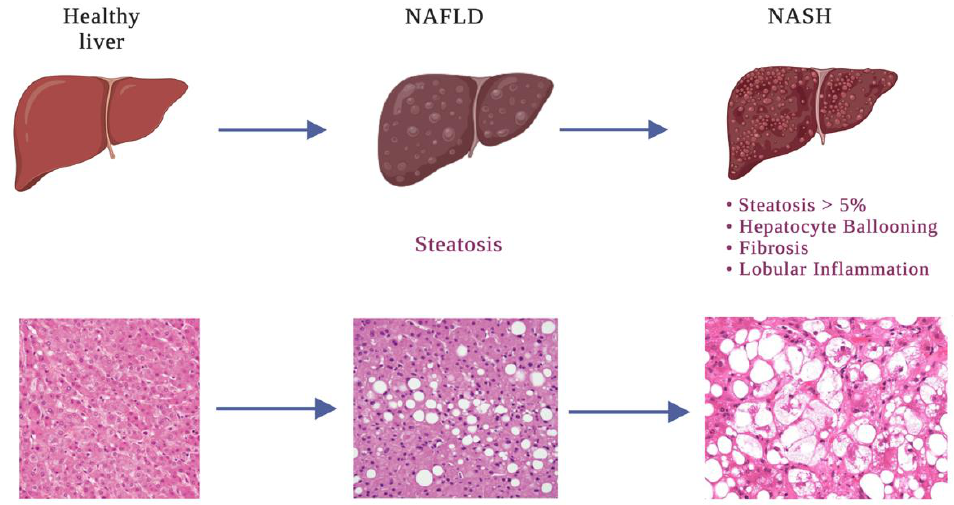
Figure 1. Different characteristics contributing to the transition from a healthy liver to the develop- ment of NASH.